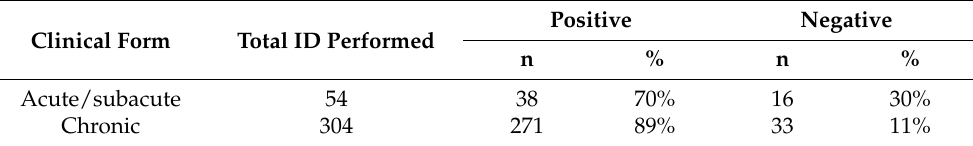
Table 7. Immunodiffusion (ID) performance in microbiological proven juvenile and chronic forms. Clinical Form